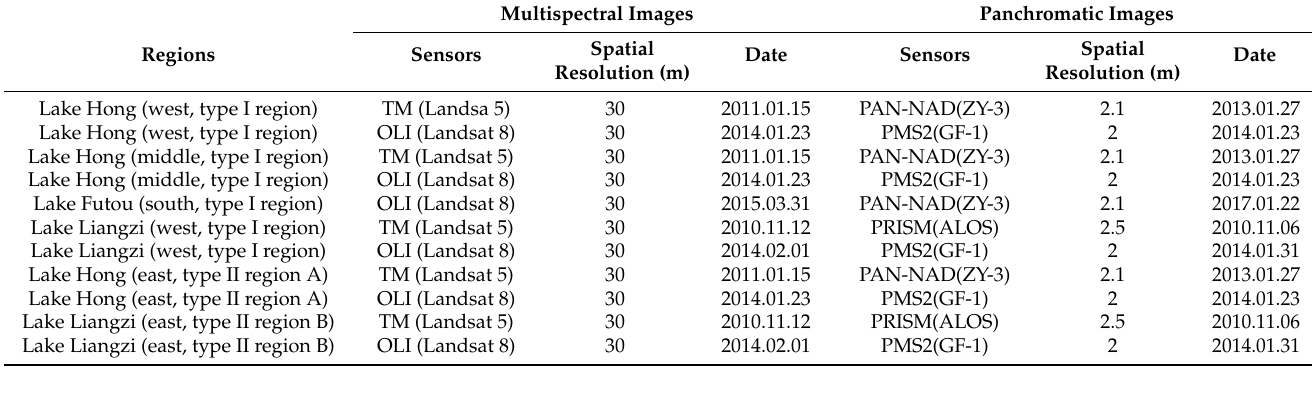
Table 1. Satellite images information for various regions.